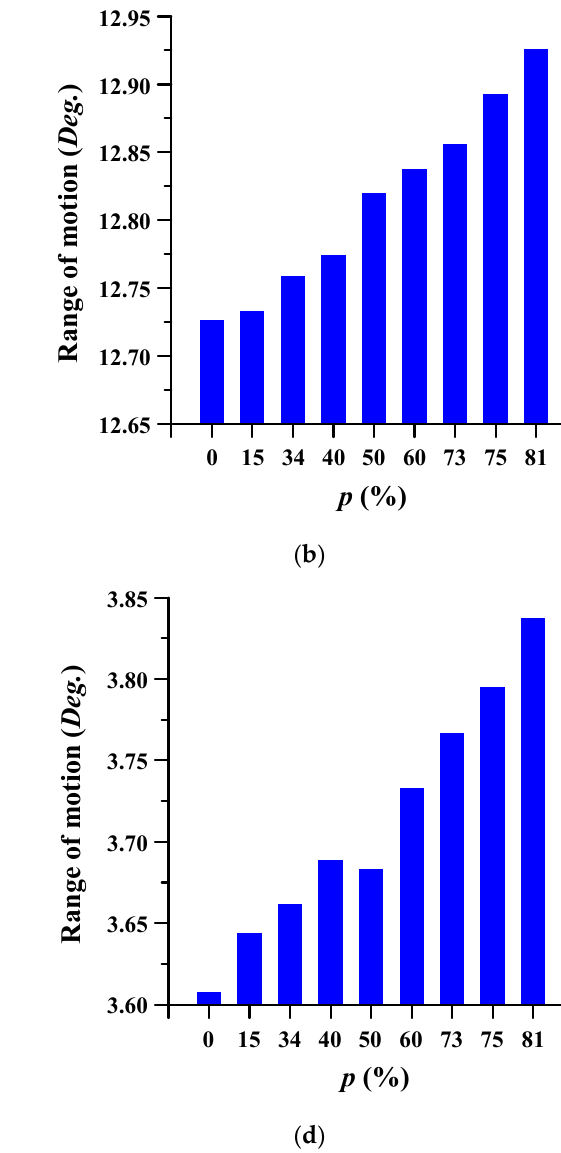
Figure 6. The range of motion (ROM) of the lumbar spine at different porosities ( p ) of the spinal implants in each spinal motion: ( a ) flexion; ( b ) extension; ( c ) lateral bending; and ( d ) rotation.